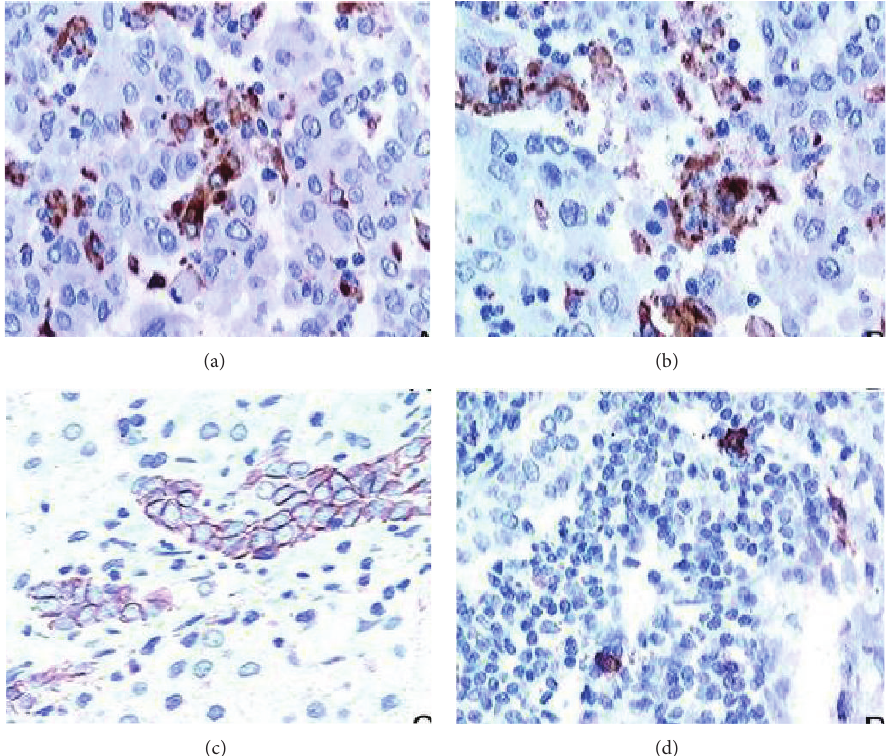
Figure 3: Interstitial immunoreactive cells infiltration, T cells (a), Kupffer cells (b), NK cells (c), and mast cells (d) were, respectively, marked CD3, CD68, CD56, and CD117 antibodies by immunohistochemical staining in HCC (IHC ×